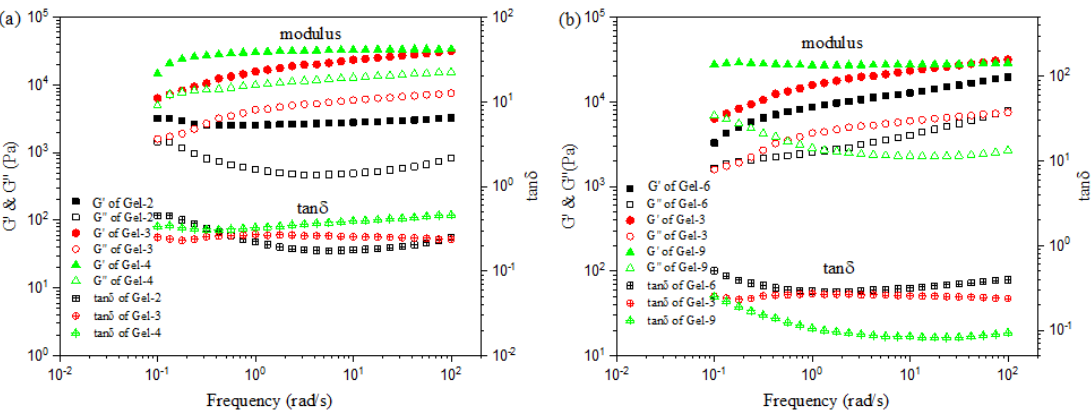
Figure 5. Variation of storage modulus (G’) and loss modulus (G’’) as function of frequency for samples measured at γ = 1%: ( a ) hydrogels with various AAc/Am ratios; ( b ) hydrogels with various Fe 3+ concentrations.